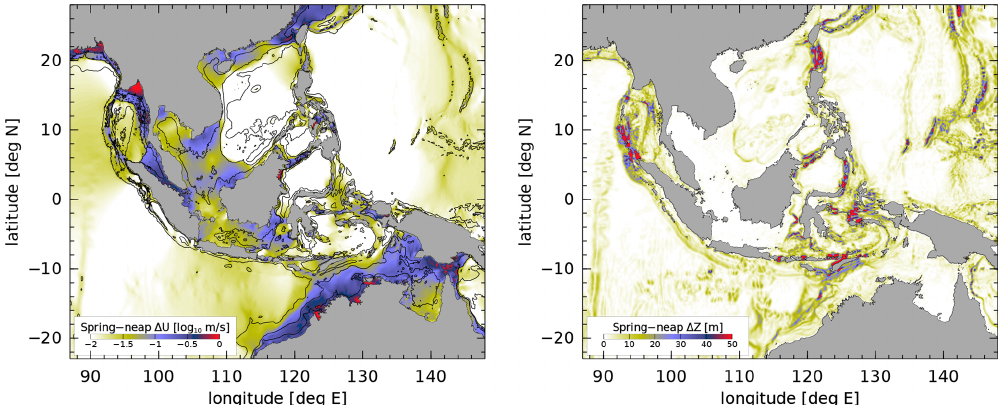
Figure 6. Diagnostics of the barotropic tidal currents, based on the TPXO9-Atlas tide model (Egbert and Erofeeva, 2002). (a) The amplitude of the combined M 2 – S 2 current at the MS f period. Solid contours show the coastline and 50, 200, and 2000m isobaths. (b) The amplitude of the vertical particle displacement due to the combined M 2 – S 2 bottom flow across